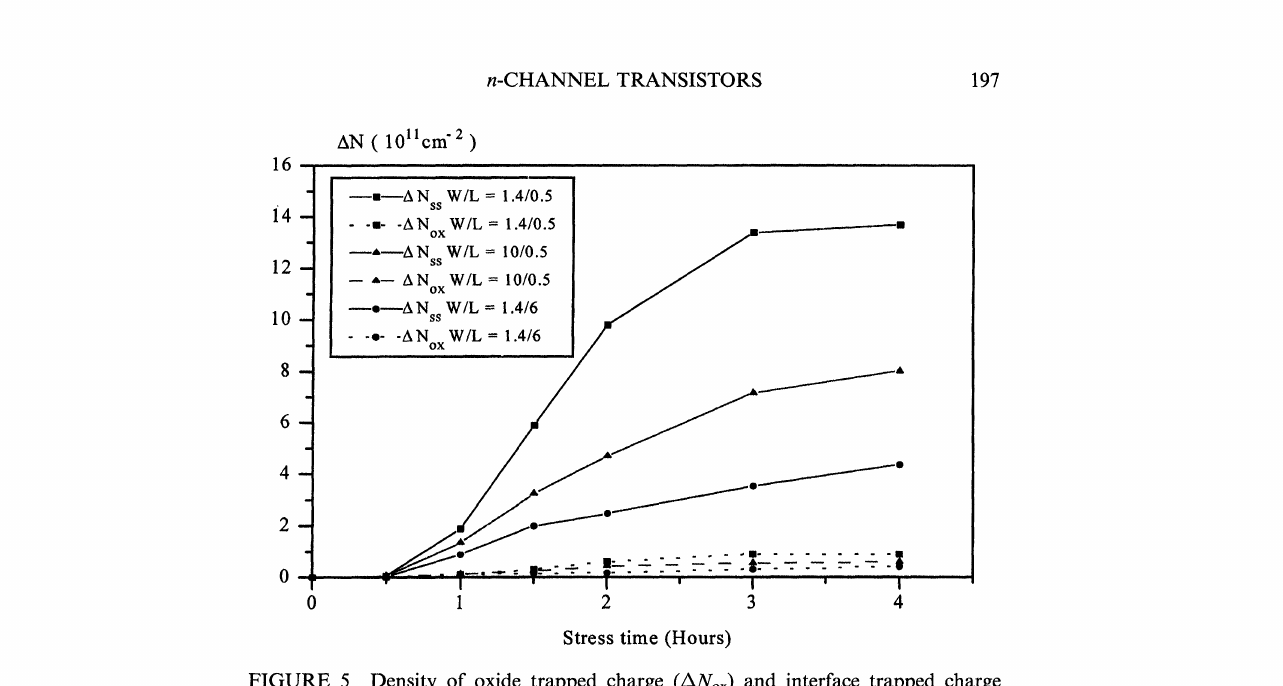
FIGURE 5 Density of oxide trapped charge (/kNox) and interface trapped charge (ANss) for different gate lengths (L) and widths (IV), during stress at Va